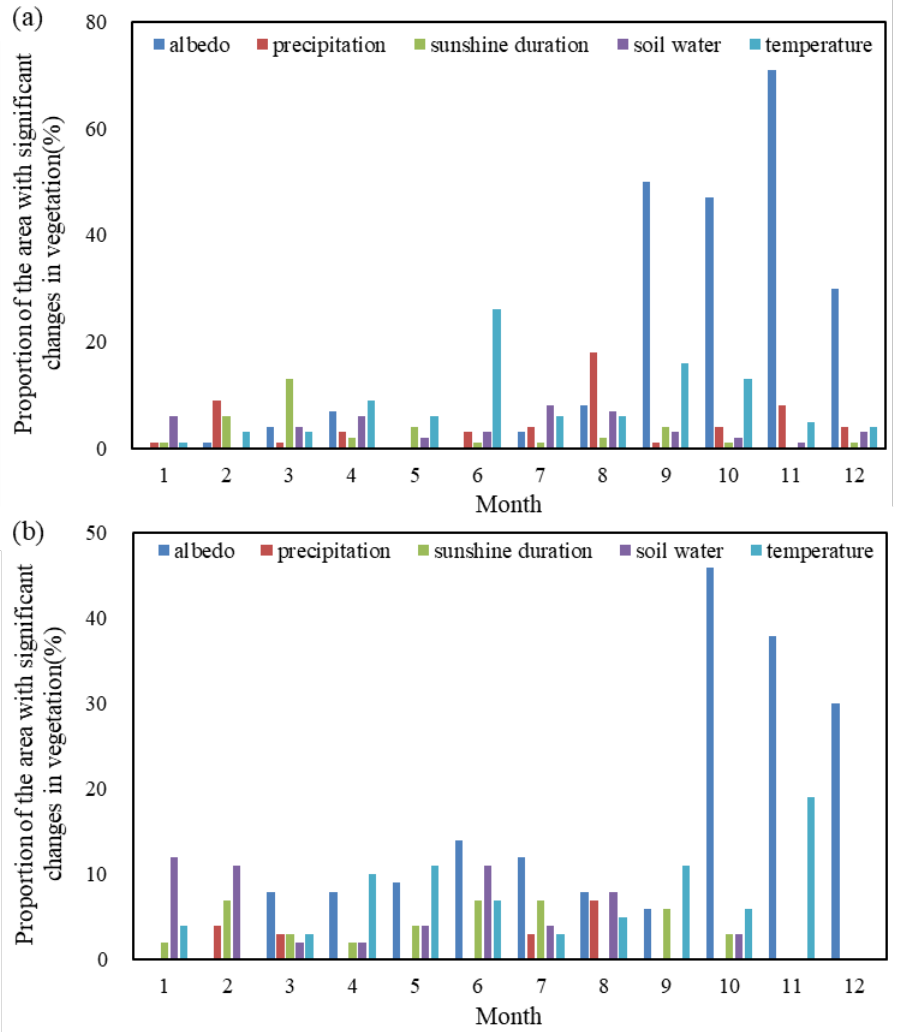
Figure 4. The proportion of the area with significant changes in vegetation caused by the major natural factors, positive impacts ( a ), and negative impacts ( b